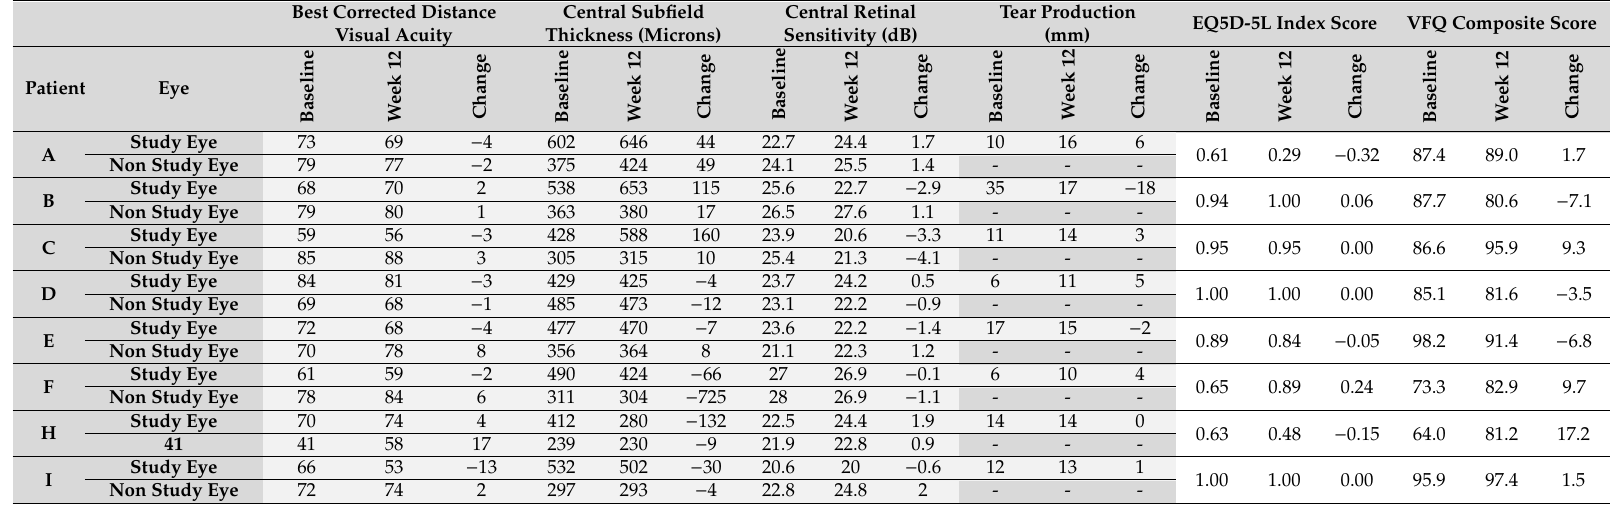
Table 4. Individual visual and patient-reported outcomes for all patients that completed the study ( n = 8) at baseline and at week 12. Best Corrected Distance Visual